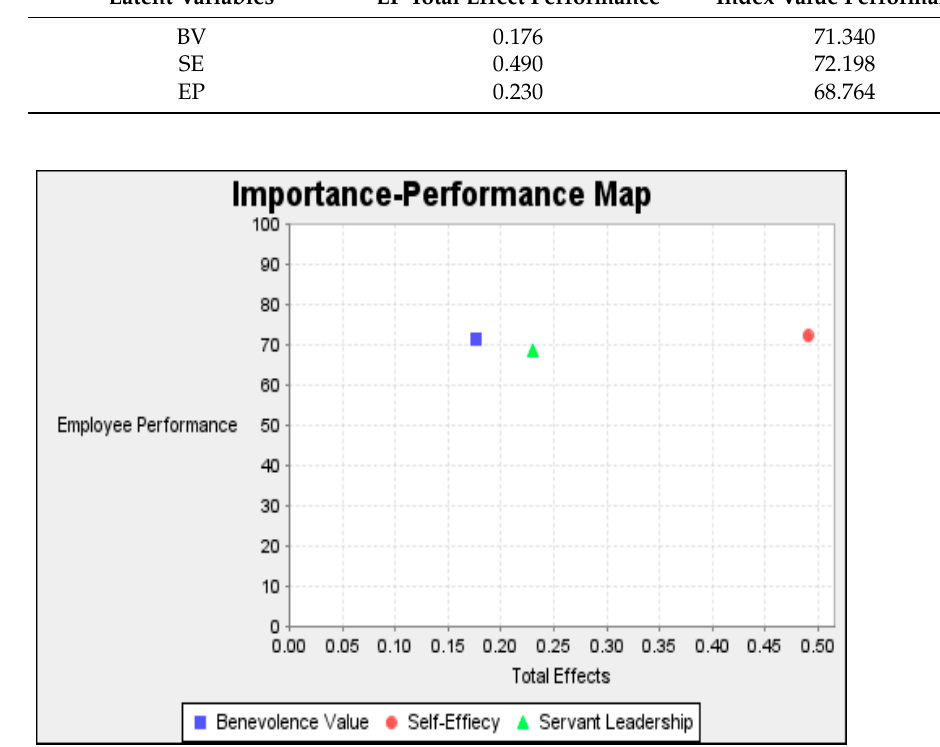
Figure 6. PLS-SEM importance–performance matrix analysis (IPMA).